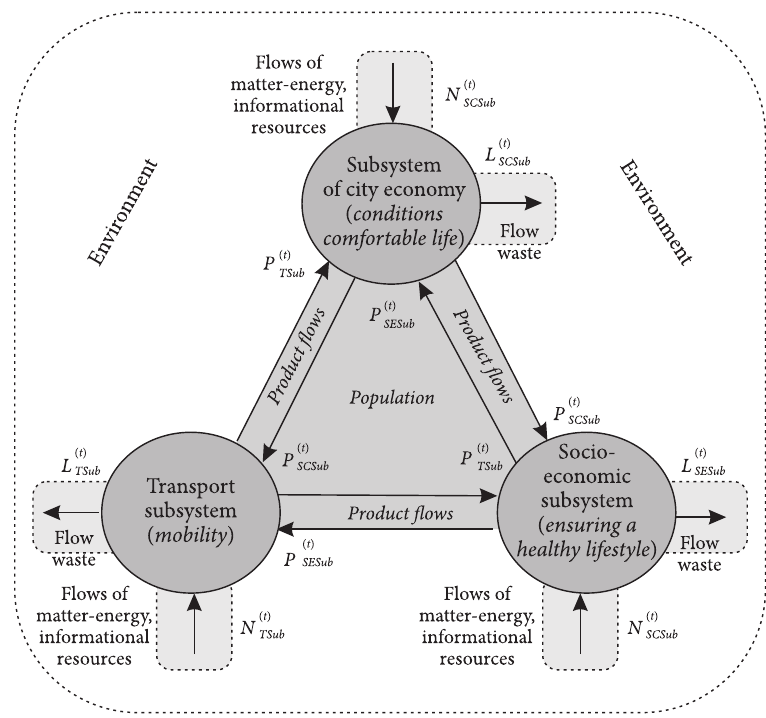
Figure 1. The scheme of exchange of material resources, information and energy between the environment and subsystems of the urban